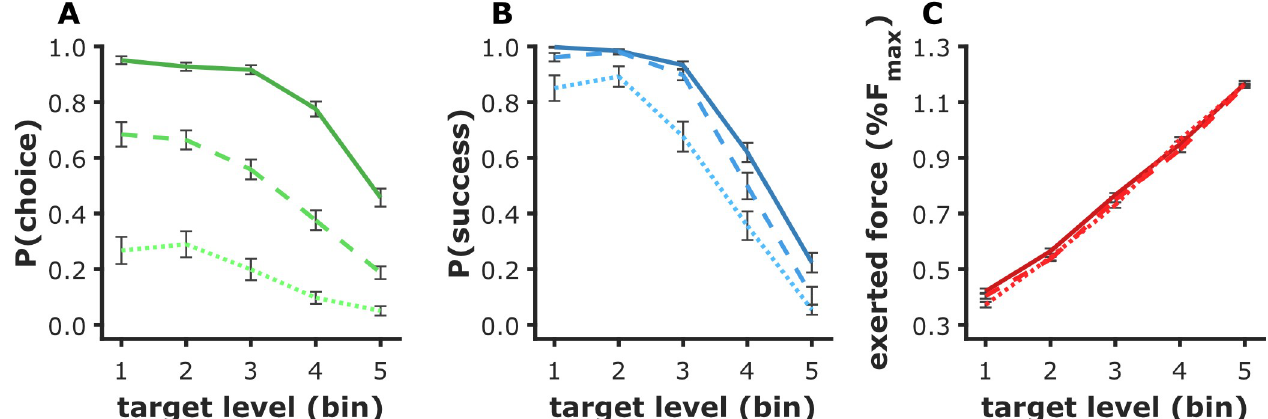
Fig 2. Action-related variables in the effort task. The three action-related dependent variables—choice (acceptance) rate (A), success rate (B), and exerted force (C) are shown as a function of target force level (imposed by the task). Only accepted trials were included in the analysis of success, and only successful trials in the analysis of force. Graphs show mean ± inter-subject SEM per force level. Darker colors and more continuous lines indicate bins (tertiles) of items with higher desirability ratings. Ratings were z-scored for every subject before binning.